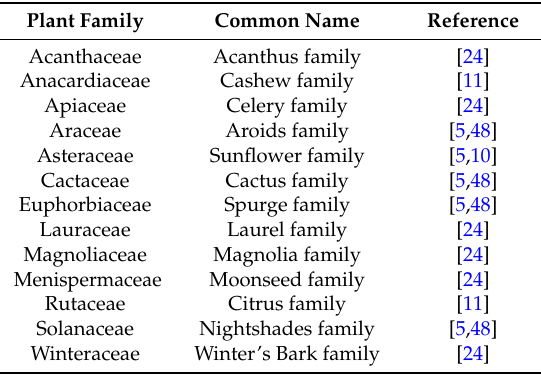
Table 1. The names of plant taxonomical families that are known producers of sesquiterpene molecules. The common names and references are also